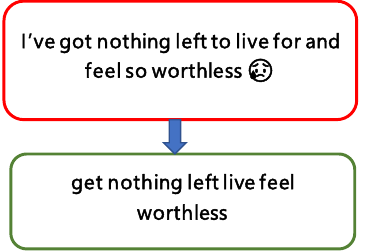
Figure 2. Example of an actual and pre-processed suicidal tweet.